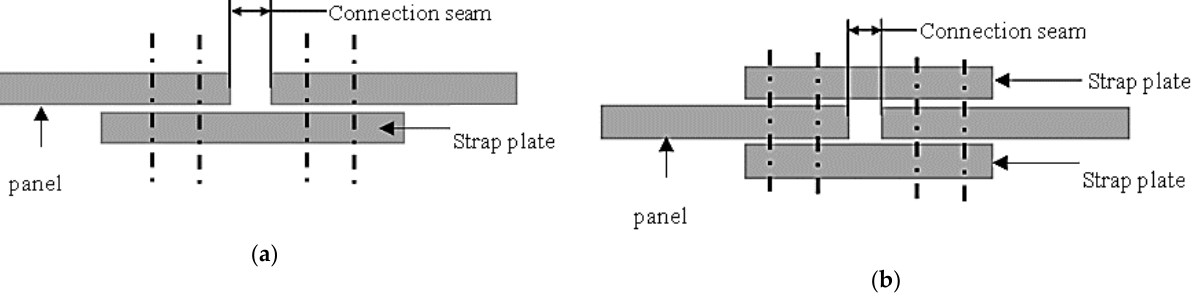
Figure 2. Schematic diagram of typical strap plate connection structures ( a ) single strap and ( b ) double strap. For the connection of sheets in aerospace structures, especially the riveting of aircraft fuselage and wing sheet structures, the process research focuses on the fatigue life, strength and residual stress of thin-walled parts caused by riveting. Stress–strain analysis is an important basis for research on riveting technology. Li et al. [2] studied the effects of clearance fit, friction coefficient, and corrosion expansion on the stress state of three-row riveted laps. The study showed that the size of clearance fit affects the maximum stress position near the top fastener hole, and the larger friction coefficient increases the contact stress and friction stress near the hole, and corrosion expansion significantly increases the stress amplitude near the hole. Cabrera et al. [3] conducted finite element analysis on basic load conditions and riveted parts of different materials, adjusted them by the least square method, and obtained polynomial expressions of stress distribution under all conditions. Eslami et al. [4] proposed a residual stress model to predict the residual stress distribution after riveting. The model is used to predict the change of the residual stress on the riveted surface, with the changing parameters being the riveted joint height, hole diameter, material properties, etc., and is verified by experiments. Atre et al. [5] studied the distribution